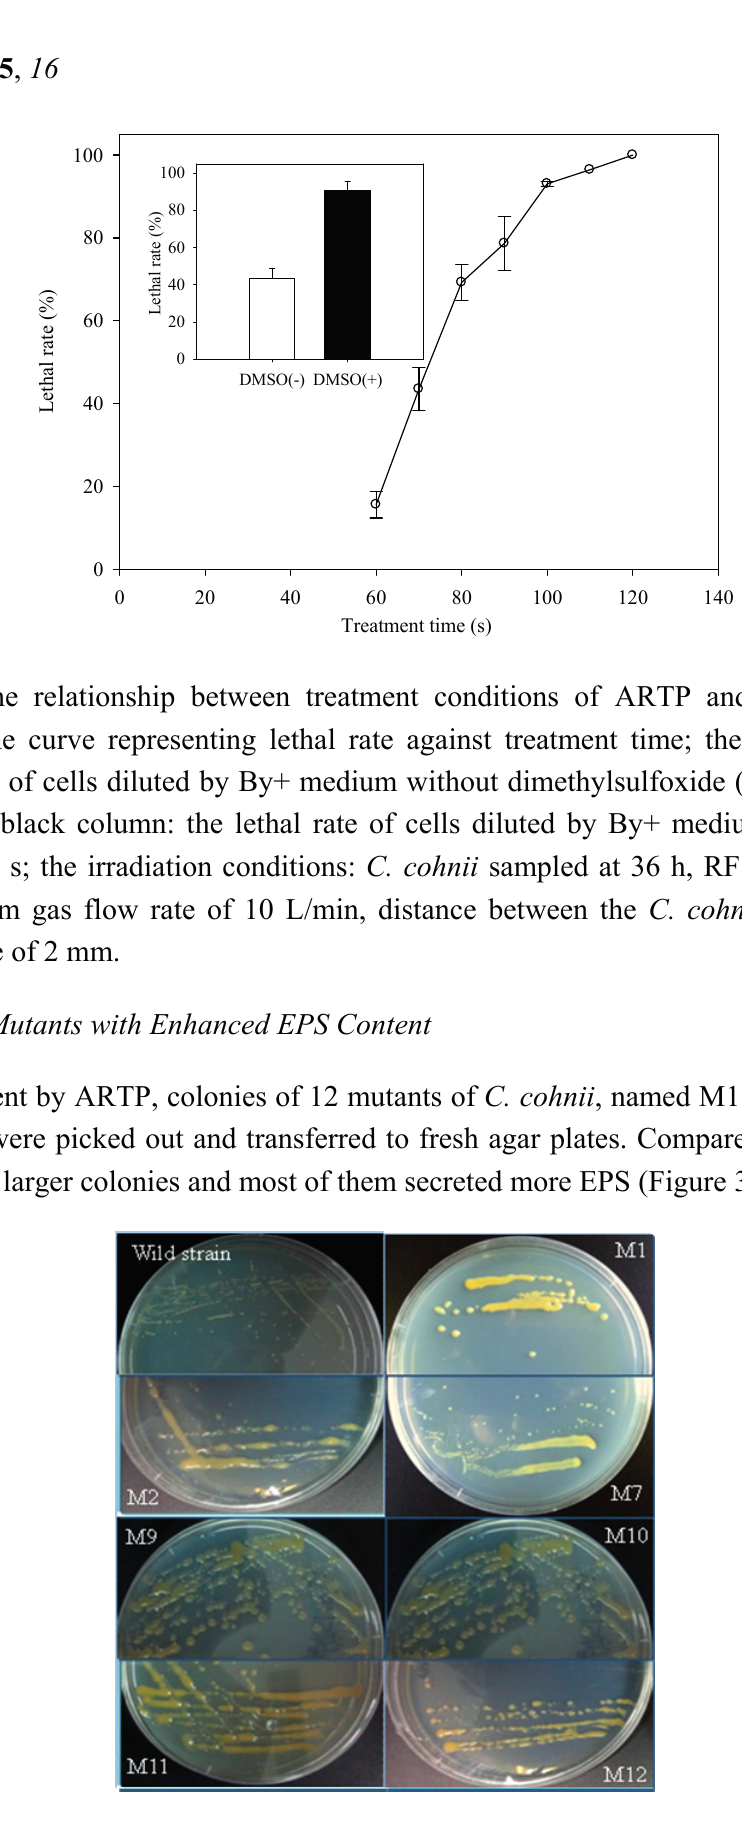
Figure 3. Colonies of wild type of C. cohnii and the mutants: the wild type and selected mutants of C. cohnii were grown on solid agar plates and incubated for 14